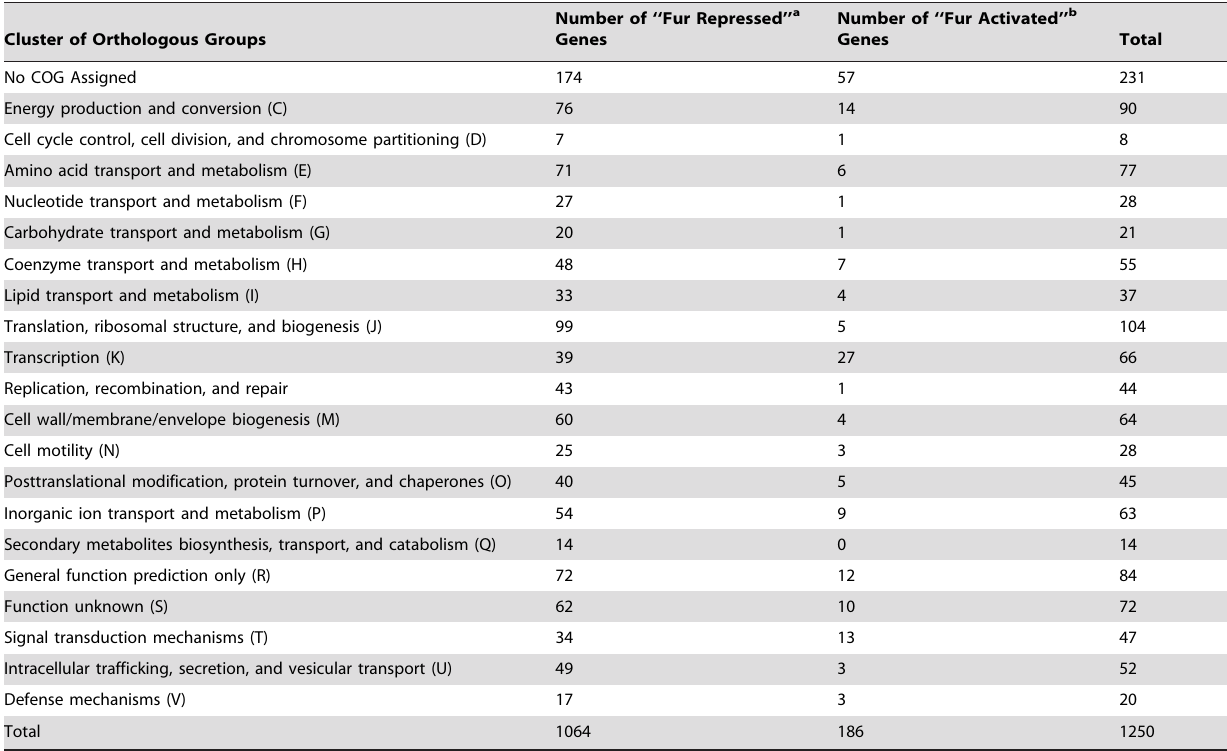
Table 1. Number of differentially expressed genes in D fur